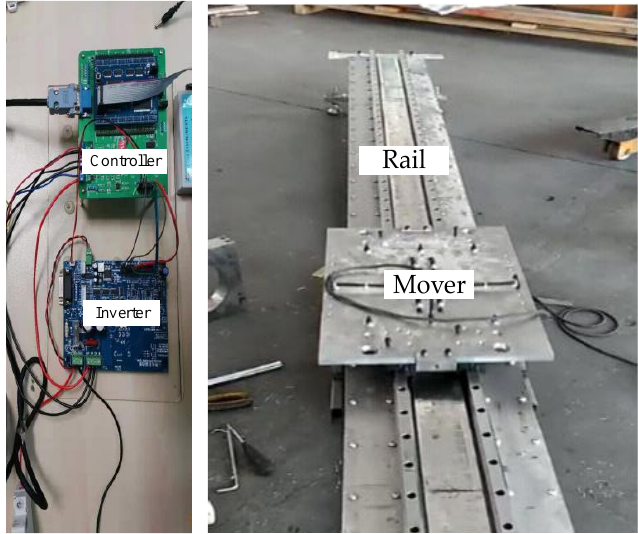
Figure 7. Experimental platform used for the test. Table 2. Parameters of PMLSM.